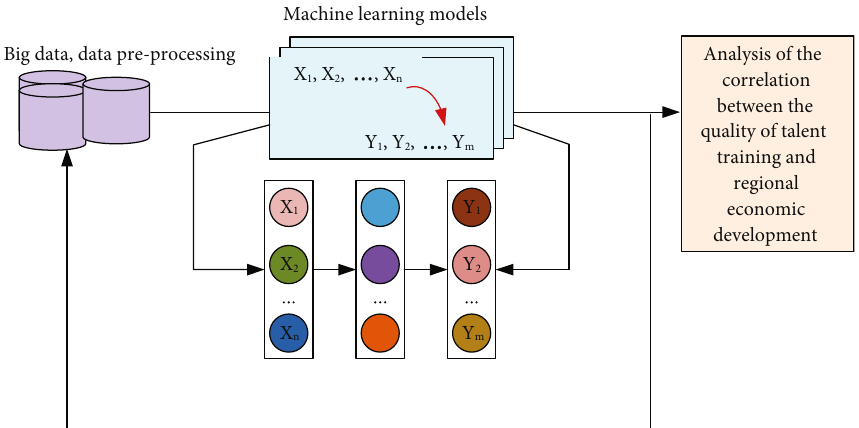
Figure 1: Machine learning algorithm-based talent development quality and economic relevance analysis